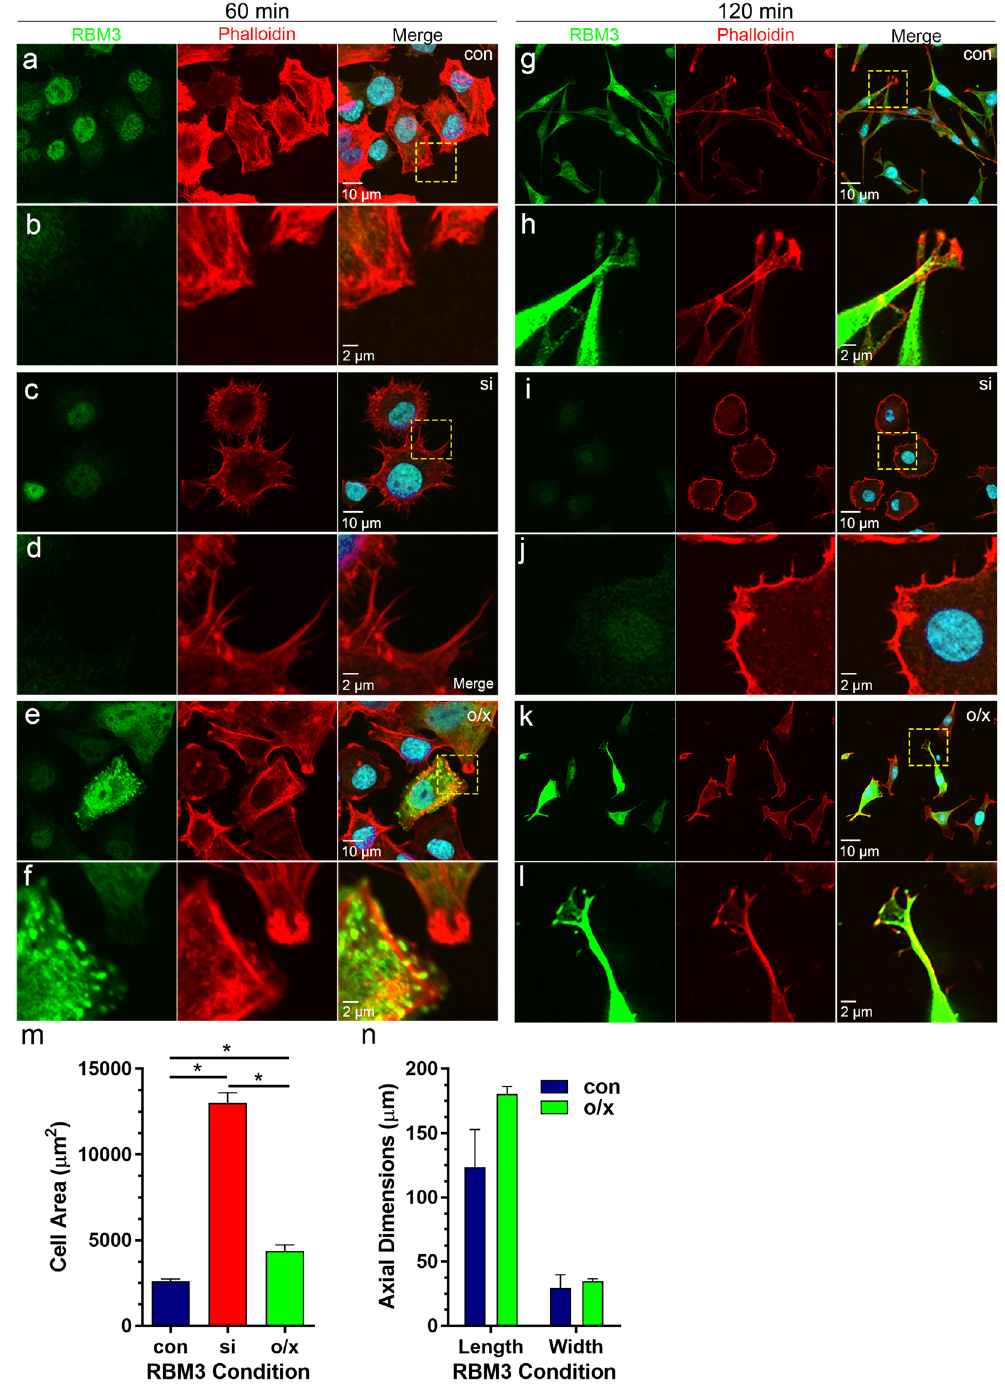
Figure 2. Perturbation of RBM3 expression alters cell spreading and morphology. B104 cells were mock transfected (con), transfected with an siRNA to knock down RBM3 (si) or transfected with a CMV-based expression vector to overexpress EYFP-RBM3 (o/x), then replated 48 hours later onto fibronectin-coated glass cover slips. Cells were fixed at 60 minutes ( a–f ) and 120 minutes ( g–l ) post plating for imaging of RBM3 (green), F-actin (red, phalloidin), and nuclei (blue, DAPI). ( a,c,e ) Images of RBM3 and F-actin in B104 cells under control ( a ), RBM3 knockdown ( c ), and RBM3 overexpression ( e ) conditions at 60 minutes post plating. ( b,d,f ) Close-up images of areas delimited by hatched yellow boxes in panels a, c, and e. Whereas control and RBM3-overexpressing cells exhibit the beginnings of cell polarity, RBM3 knockdown cells adopted a highly rounded or polygonal morphology with prominent microspikes. ( g,i,k ) images of RBM3 and F-actin in B104 cells plated as in panels, a,c,e, but fixed at 120 minutes. At this timepoint, cells lacking RBM3 adopt markedly different shapes than control and RBM3-overexpressing cells. ( h,j,l ) close-ups of areas delimited within panels g, i, and k. Whereas control and RBM3-overexpressing cells were elongated in a polar morphology with